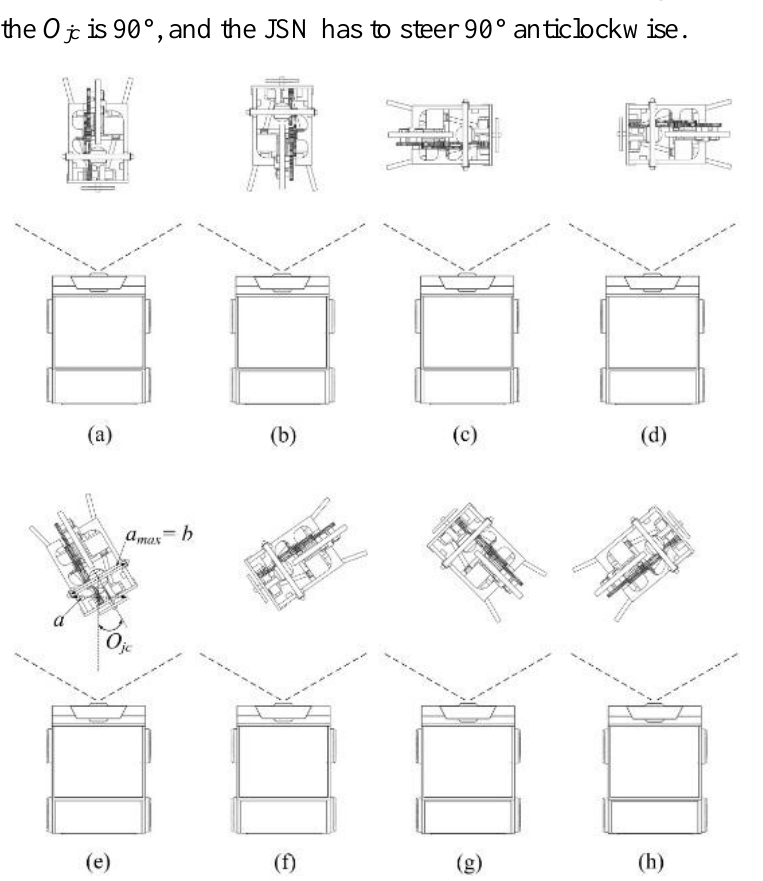
Figure 6. Eight conditions of the orientation of the JSN relative to the carrier: ( a ) JSN faces to the front side of the carrier; ( b ) JSN backs onto the front side of the carrier; ( c ) JSN faces to right side of the carrier; ( d ) JSN faces to left side of the carrier; ( e ) JSN faces to the front-right side of the carrier; ( f ) JSN faces to the front-left side of the carrier; ( g ) JSN backs onto the front-right side of the carrier; ( h ) JSN backs onto the front-left side of the